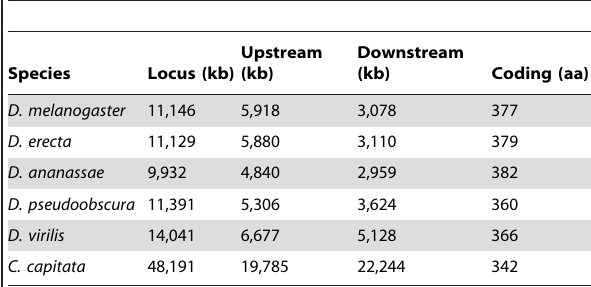
Table 2. Sizes of even-skipped locus (MAS enhancer to stripe 4/6